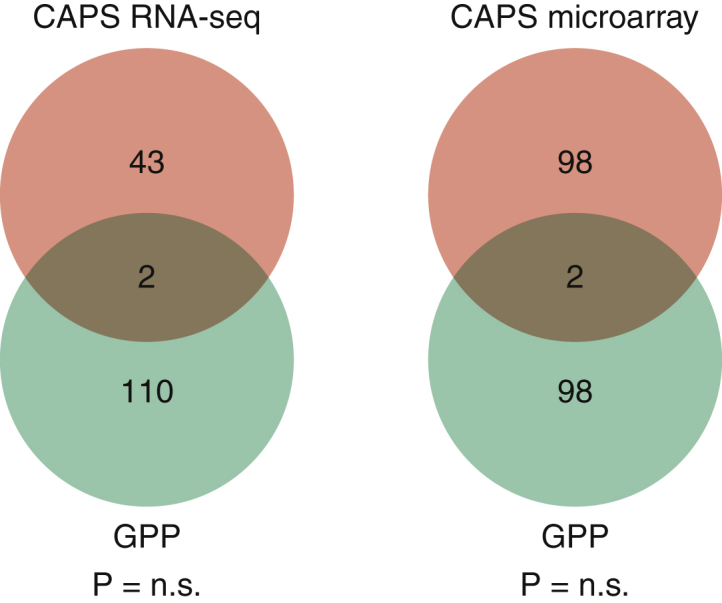
Lack of evidence for an IFN signature in the leukocytes of patients. Venn diagrams showing the overlap between the genes that are upregulated in GPP and in the CAPS datasets analyzed by Canna et al. (CAPS-1) and Balow et al. (CAPS-2). Neither overlap was statistically significant. CAPS, cryopyrin associated periodic syndrome; GPP, generalized pustular psoriasis.